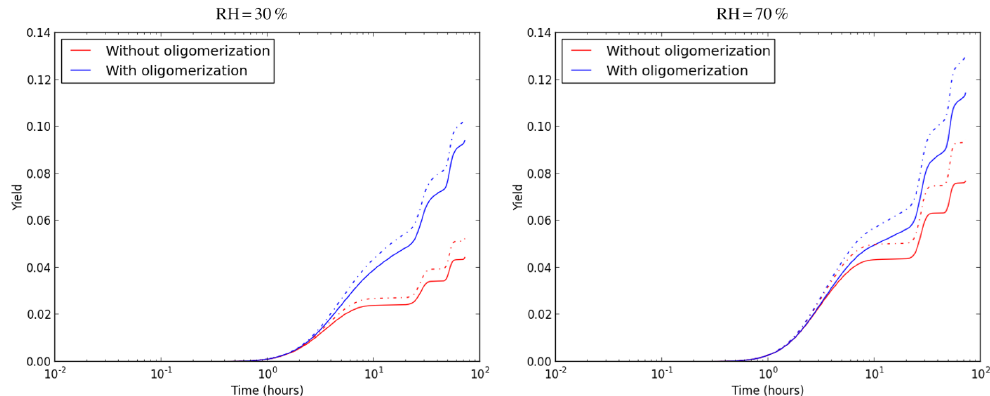
Figure 6. Evolution of the SOA yield from toluene oxidation as a function of time for an organic mass loading of 5µgm − 3 . Solid lines correspond to SOA formation with aging. Dashed-dotted lines correspond to SOA formation without